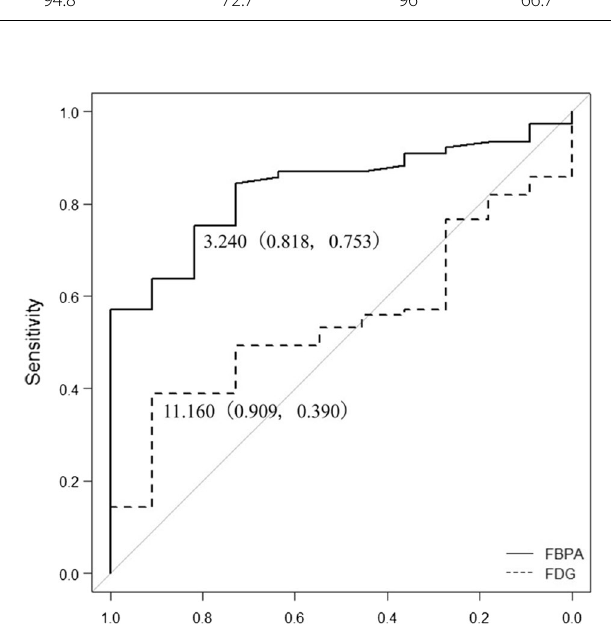
Fig. 4 ROC curves for SUVmax on 18 F-FDG (broken line) and 18 F-FBPA (solid line)